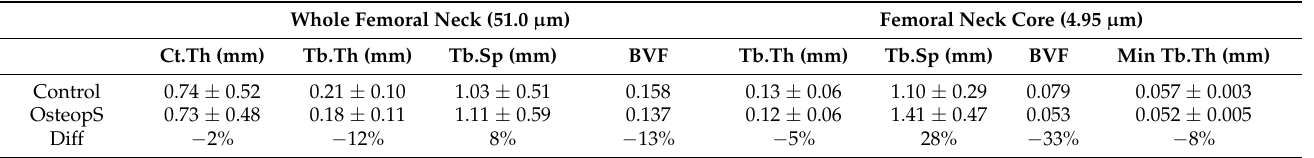
Table A1. Morphological analysis of the whole femoral neck and its core for both the osteoporotic and control